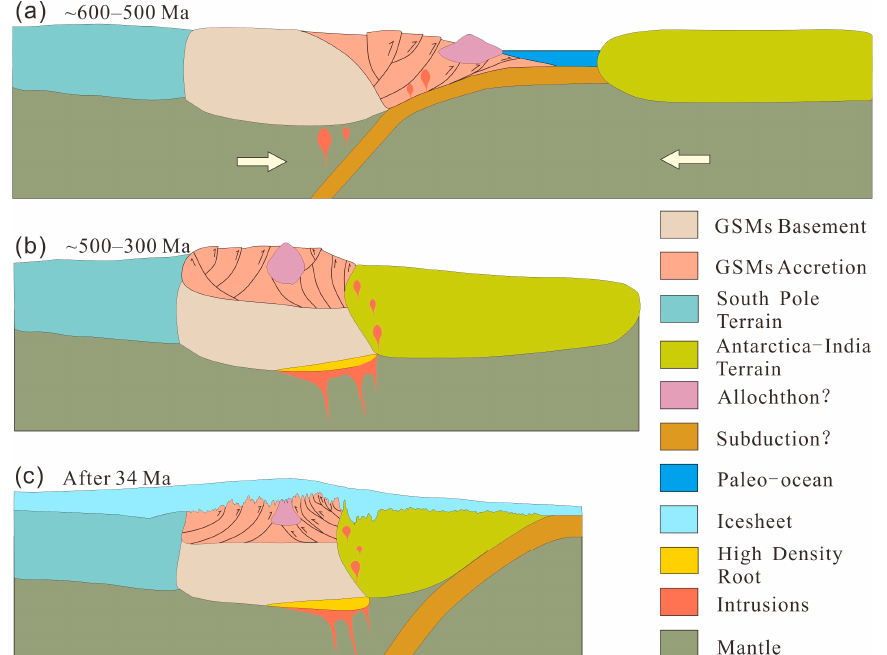
Figure 6. Schematic cross sections of the GSMs orogen. ( a ) Schematic tectonic evolution of the GSMs at the beginning of the Gondwana convergence (~600–500 Ma). ( b ) Schematic tectonic evolution of the GSMs after the Antarctic and Indian plates completed collisional convergence (~500–300